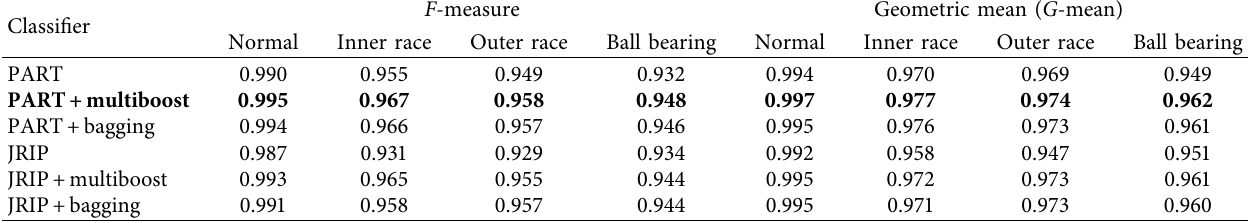
Table 10: Classifier performance in terms of F -measure and G -mean values for Exp. 2.